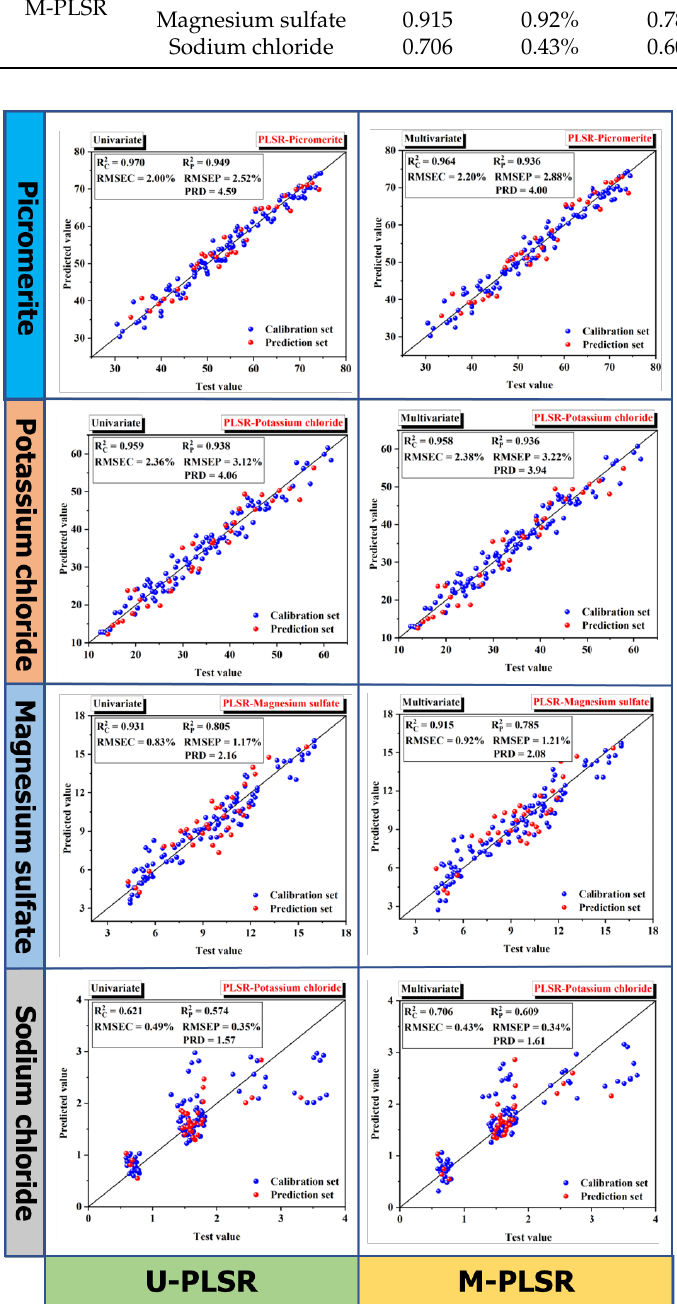
Figure 9. Prediction results of U-PLSR and M-PLSR models for MP